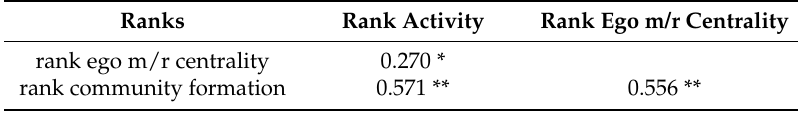
Table 2. Spearman’s correlation coefficients between pairs of the three ranks.